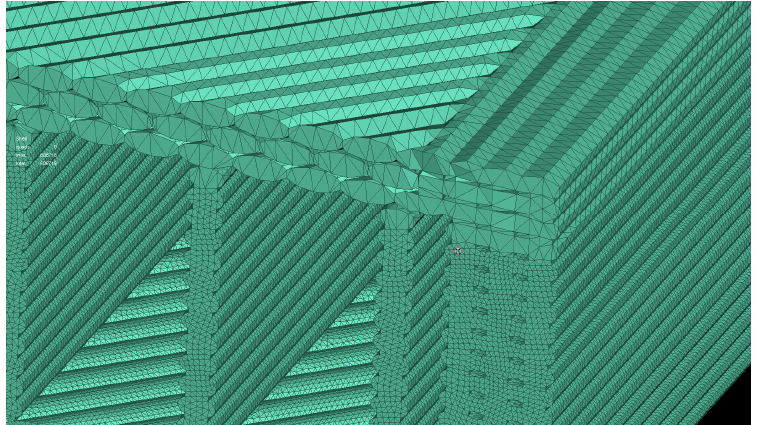
Figure 12. Influence of the higher target length on the representation of the individual filaments.